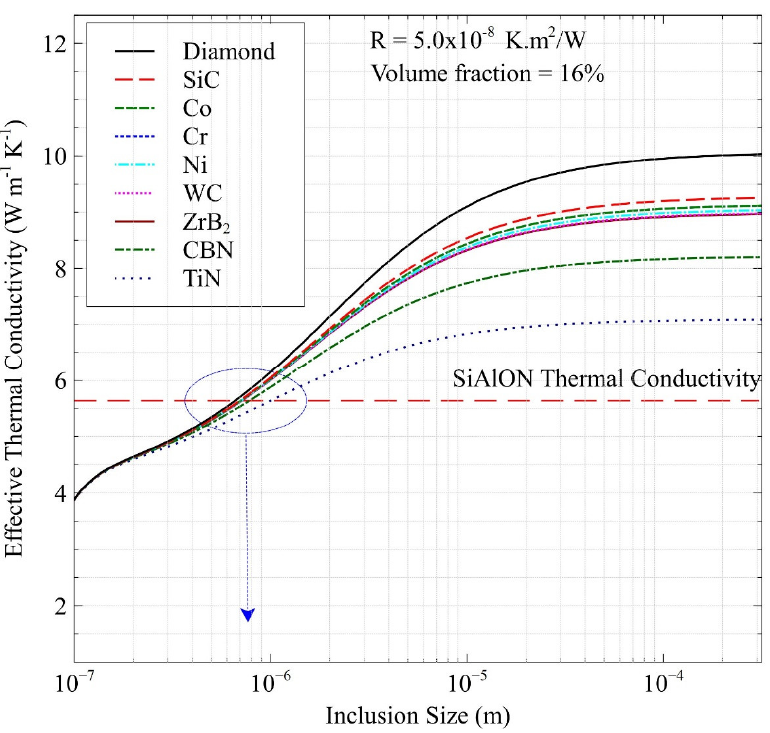
Figure 3. Determination of threshold particle size of reinforcements in the Ca-α-SiAlON composites for enhanced effect on thermal conductivity. Numerous metal and ceramic particles are considered with a porosity of 2%, thermal interface resistance (R) of 5.0 × 10 −8 K.m 2 /W, and volume fraction of 16%.